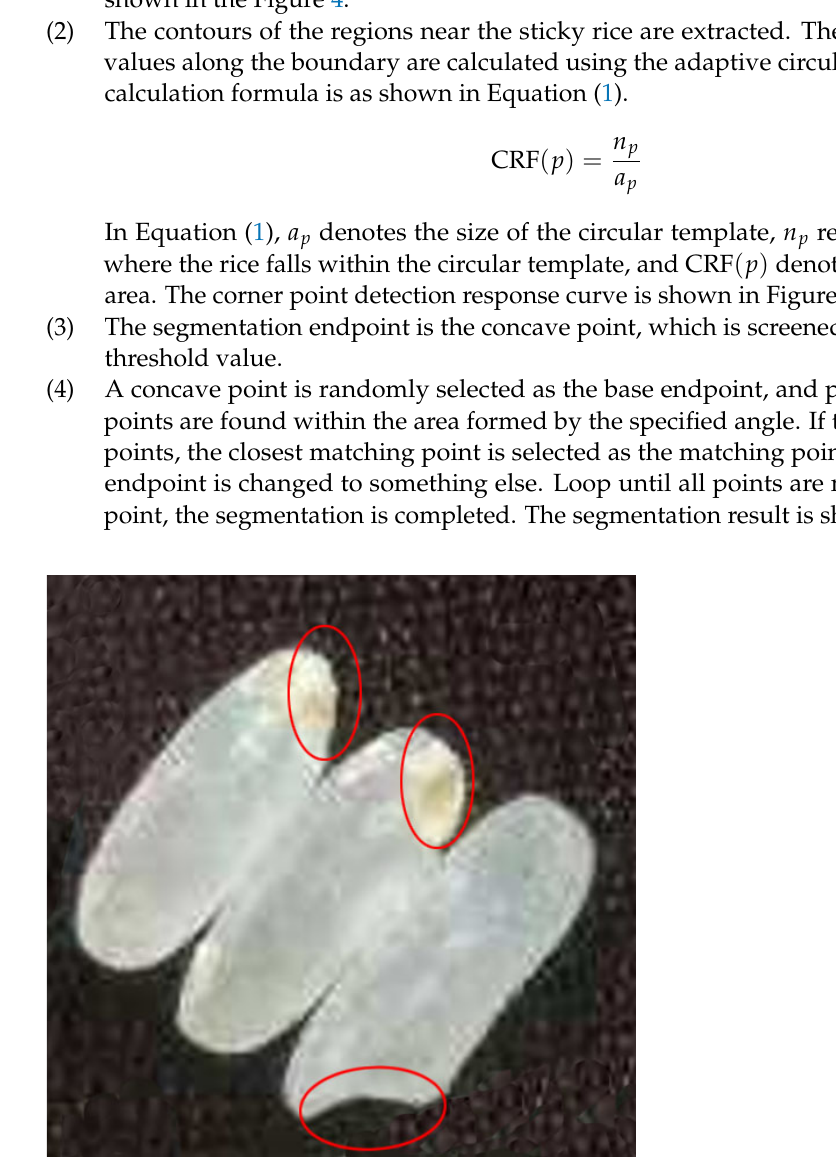
Figure 4. Image of rice seeds with various degree of germ integrity. The red oval indicates the position of the